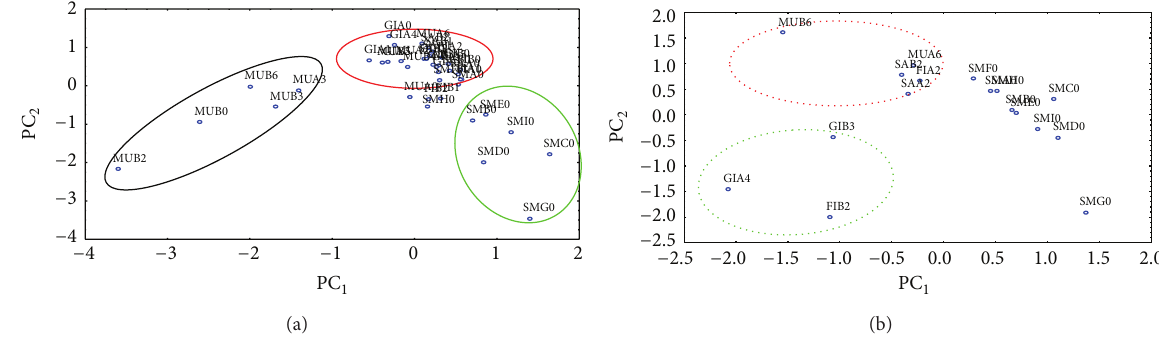
Figure 3: (a) Results of PCA applied to the overall dataset after autoscaling: score plot of PC 1 versus PC 2 ; (b) results of PCA applied to the samples analysed at the selling time after autoscaling: score plot of PC 1 versus PC 2 .